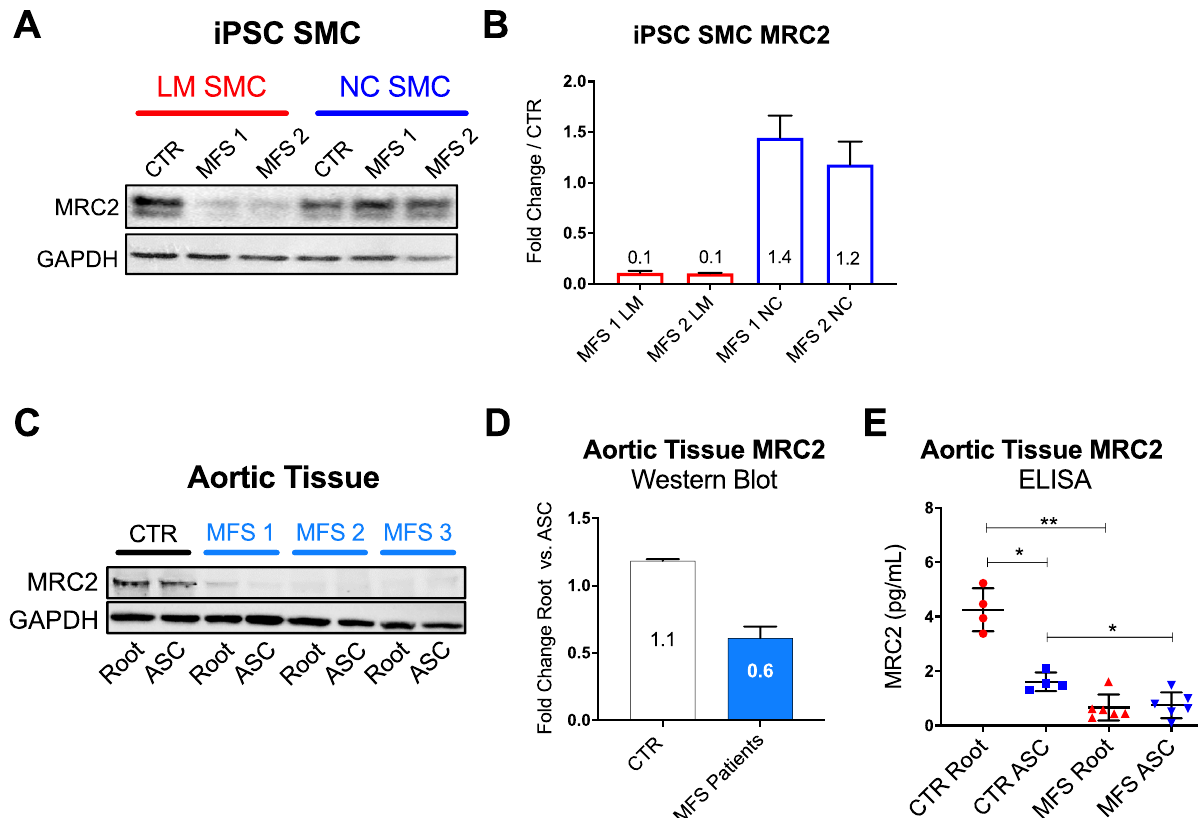
Figure 4. Downregulated MRC2 expression predicted by iPSC SMC iTRAQ analysis is dysregulated in human MFS aortic aneurysm specimens. ( A ) Western blot analysis of mannose receptor 2 (MRC2) in both LM and NC originated iPSC SMC; ( B ) Quantification of MRC2 expression ratio for MFS patients to control in denoted lineage. ( C ) Representative western blot analysis of mannose receptor 2 (MRC2) in human aortic tissue lysates from MFS patients (n = 3) and healthy organ donor control. Root = aortic root (Sinus of Valsalva), ASC = ascending aorta. ( D ) Quantitative comparison of Root vs ASC MRC2 expression by western blot in aortic tissue samples. ( E ) ELISA results of MRC2 levels in aortic tissues of control patients (N = 4) vs. MFS patients (N = 6). Western blots from iPSC SMC lines represent at least three technical replicates from the indicated sample. Groups tested by ELISA were compared by non-parametric analysis, Mann–Whitney rank sum test. Significance is assigned based on the P -value ( P < 0.05, ** P < 0.01, *** P < 0.001) where n stands for biological replicates (n = 4 for controls, and n = 6 for MSF